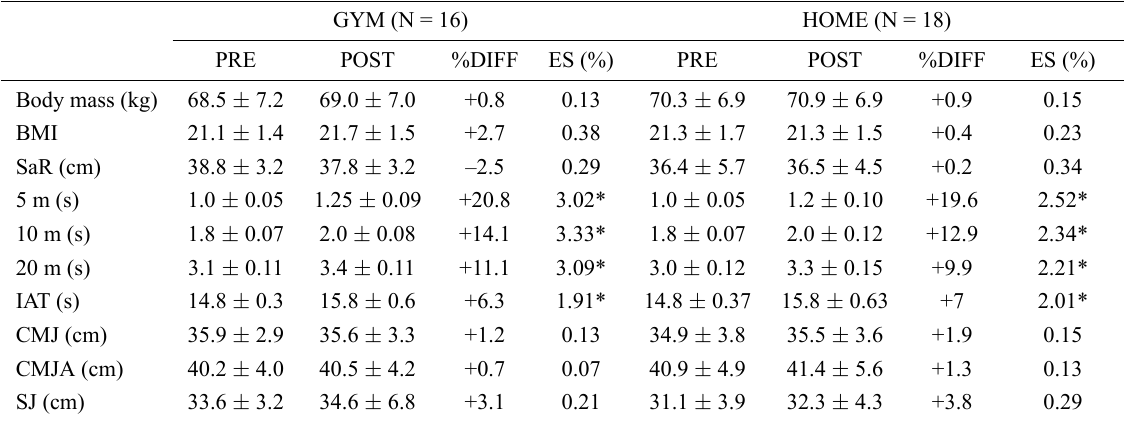
Table 5. Mean values ± SD and differences for GYM vs. HOME group before (pre) and after (post) 3 weeks of experimental period. GYM (N = 16) HOME (N = 18) PRE